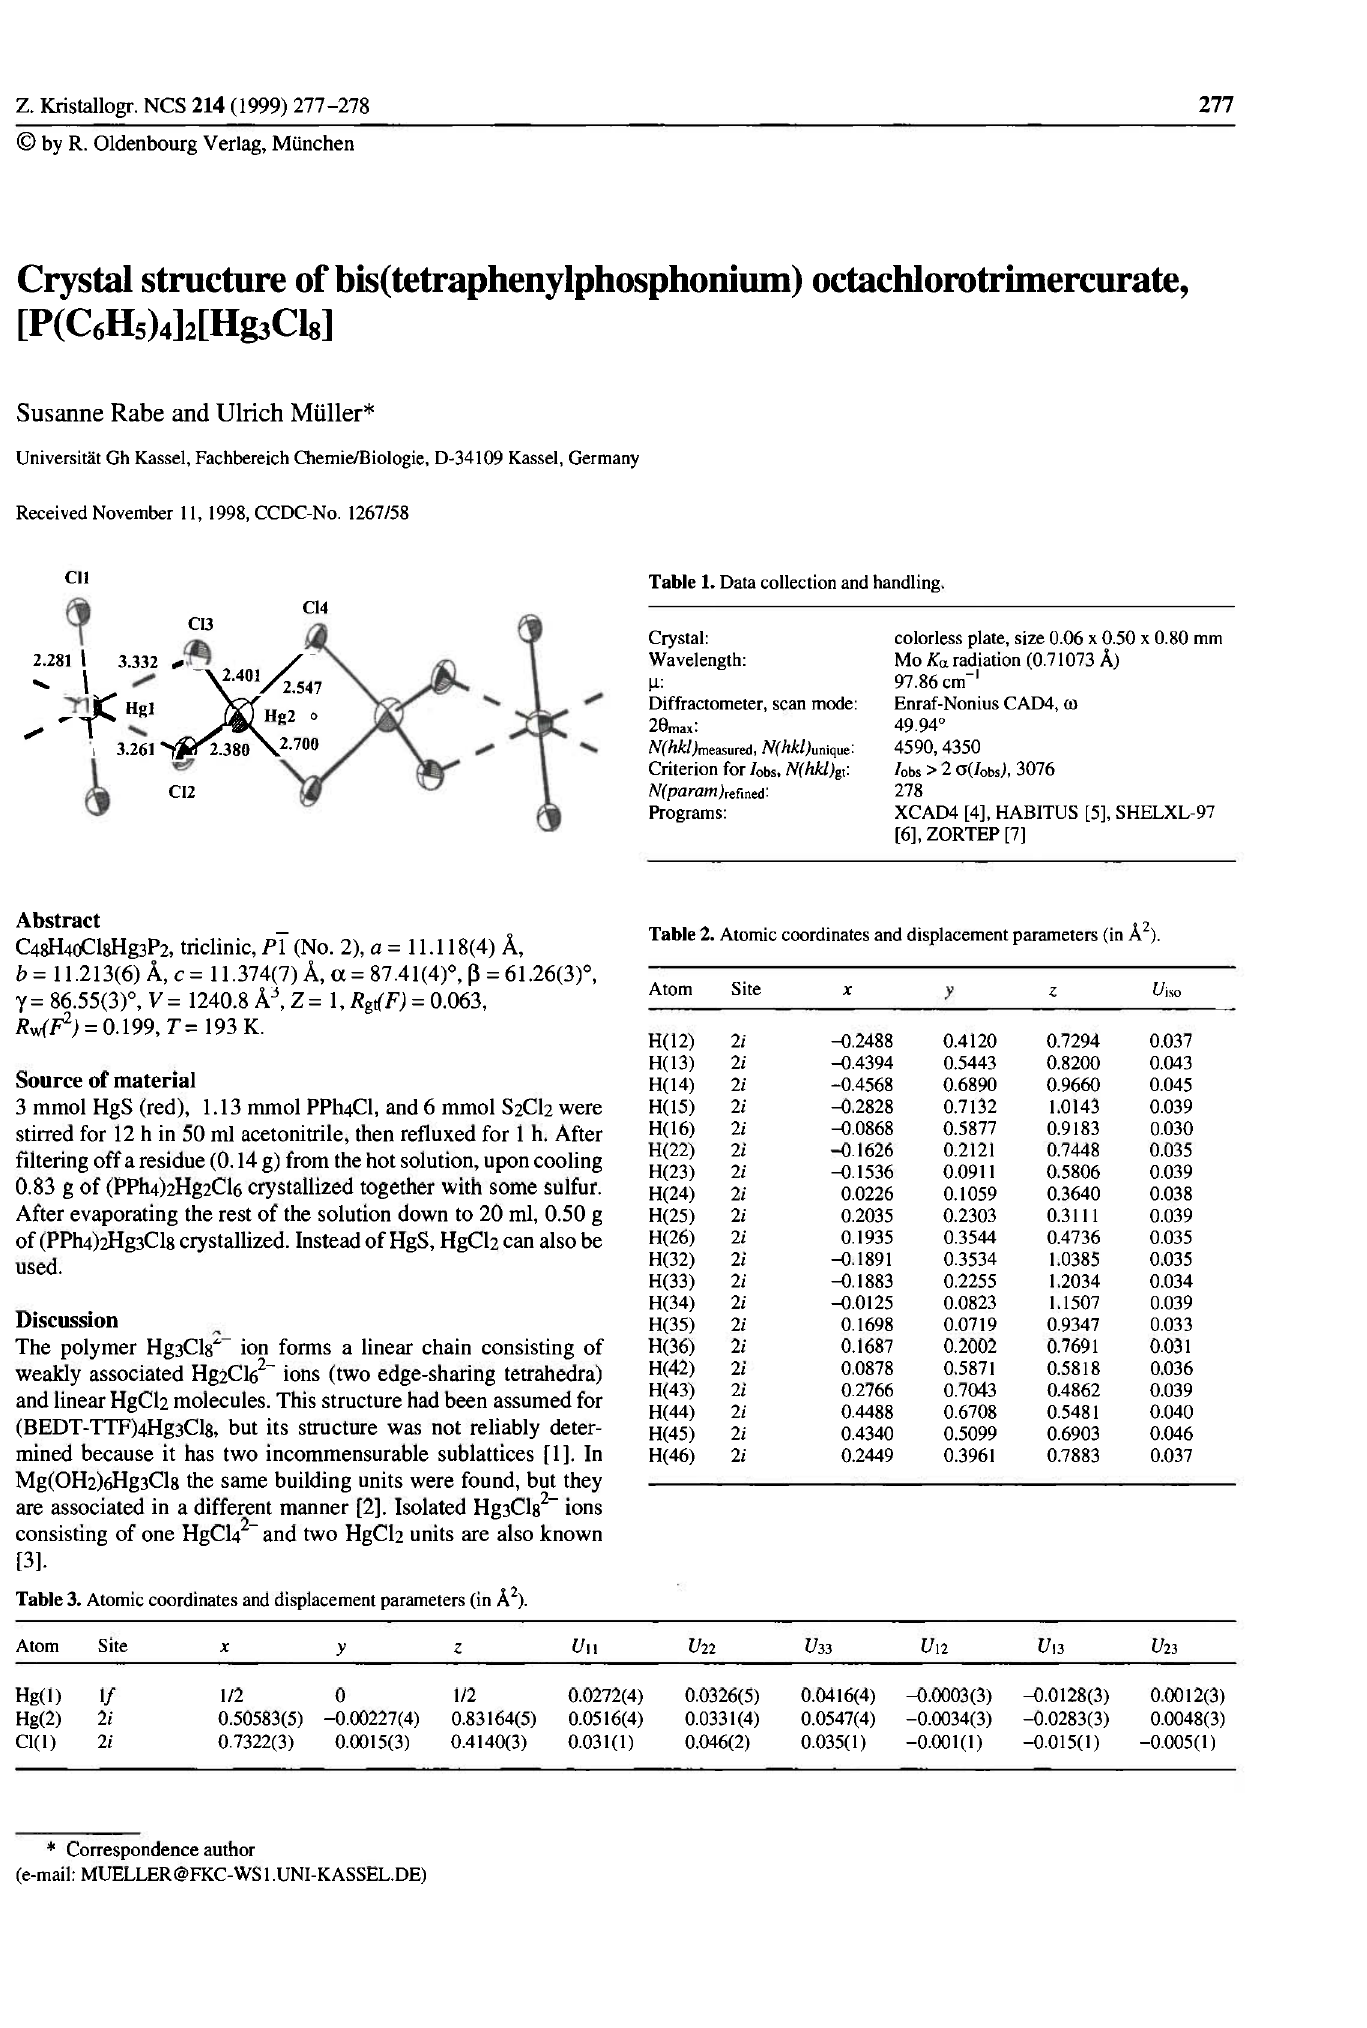
Table 1. Data collection and handling. Crystal: Wavelength: